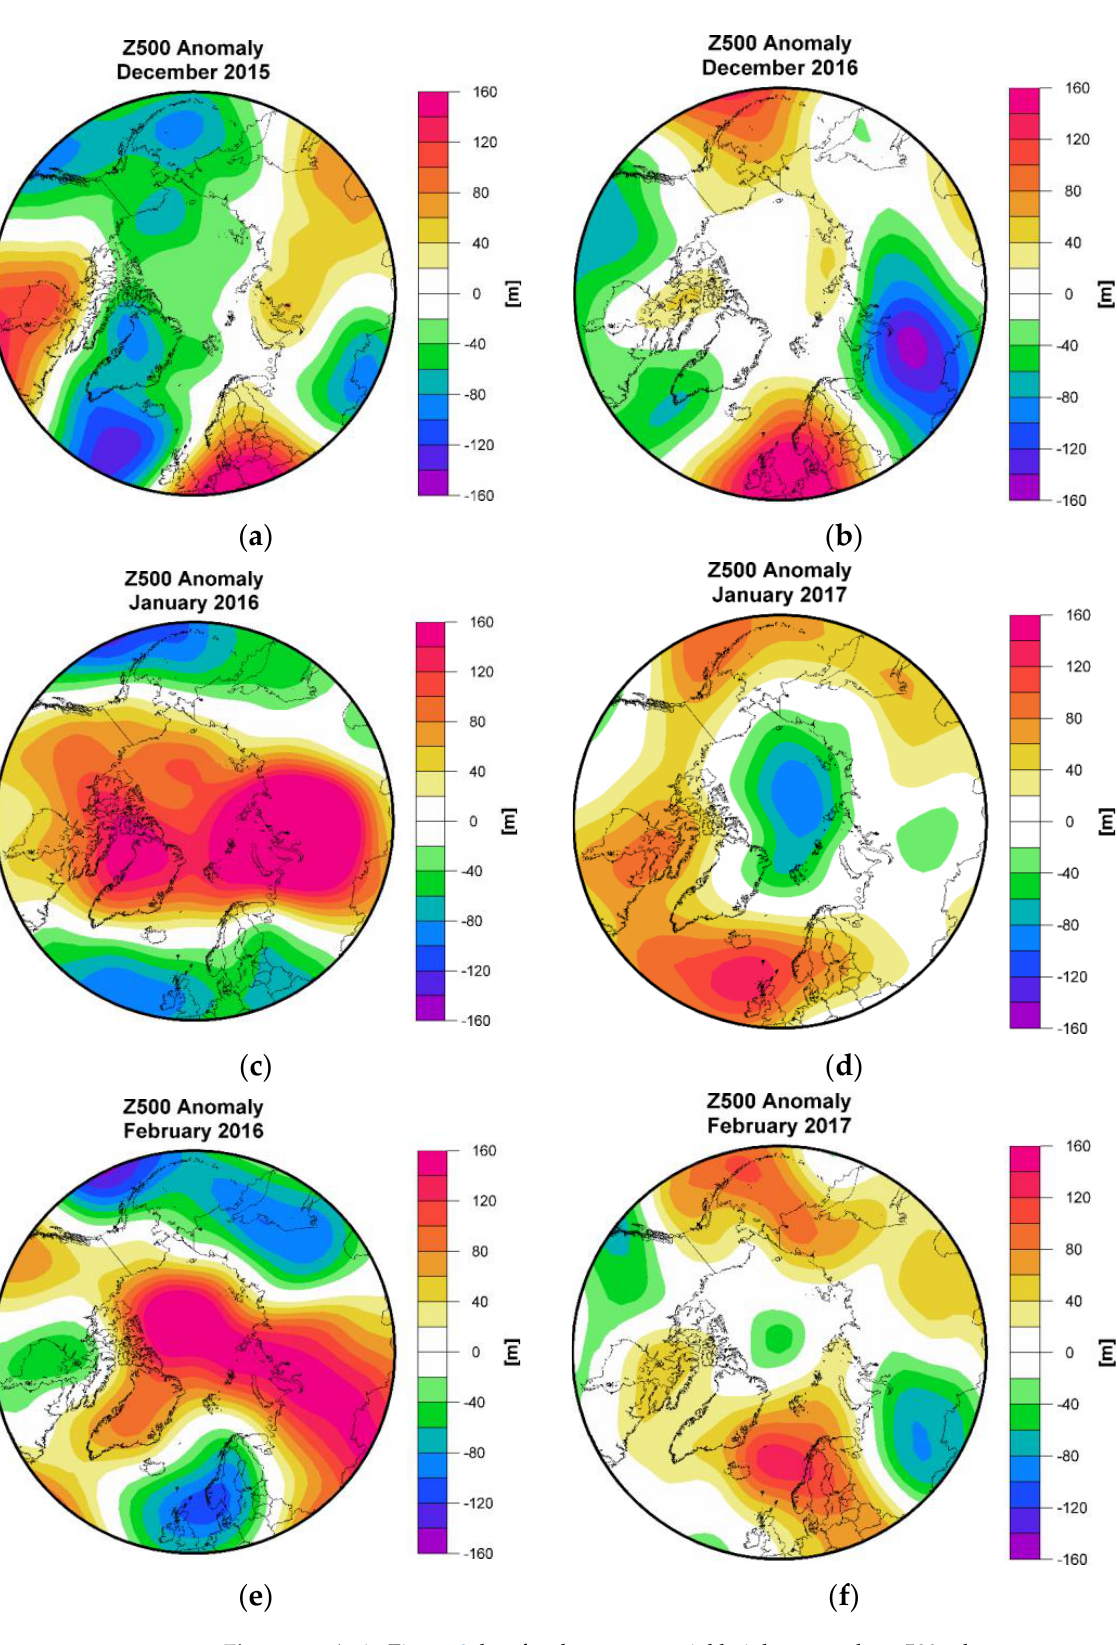
Figure 10. As in Figure 9, but for the geopotential height anomaly at 500 mb.